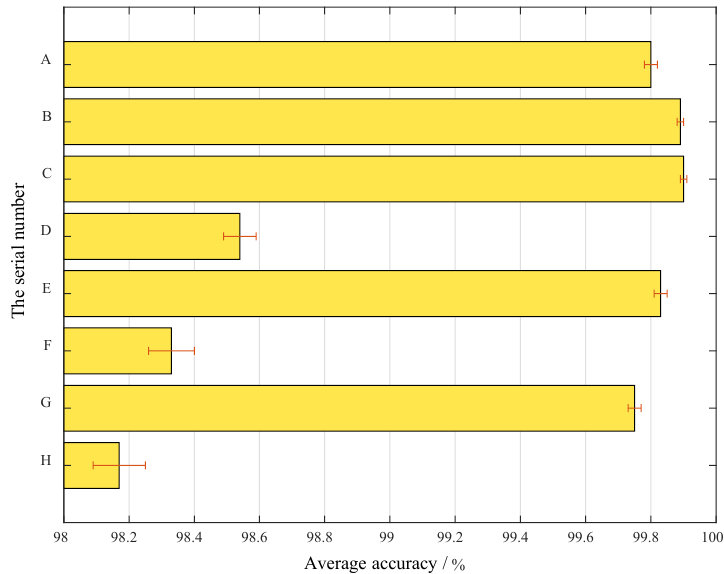
Figure 9. Experimental results of model performance